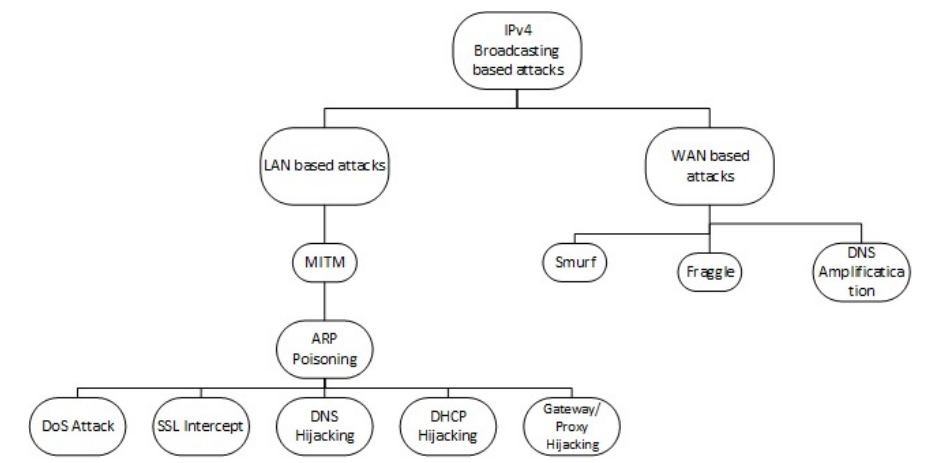
Figure 1. Taxonomy of attacks due to IPv4 broadcasting. MITM,